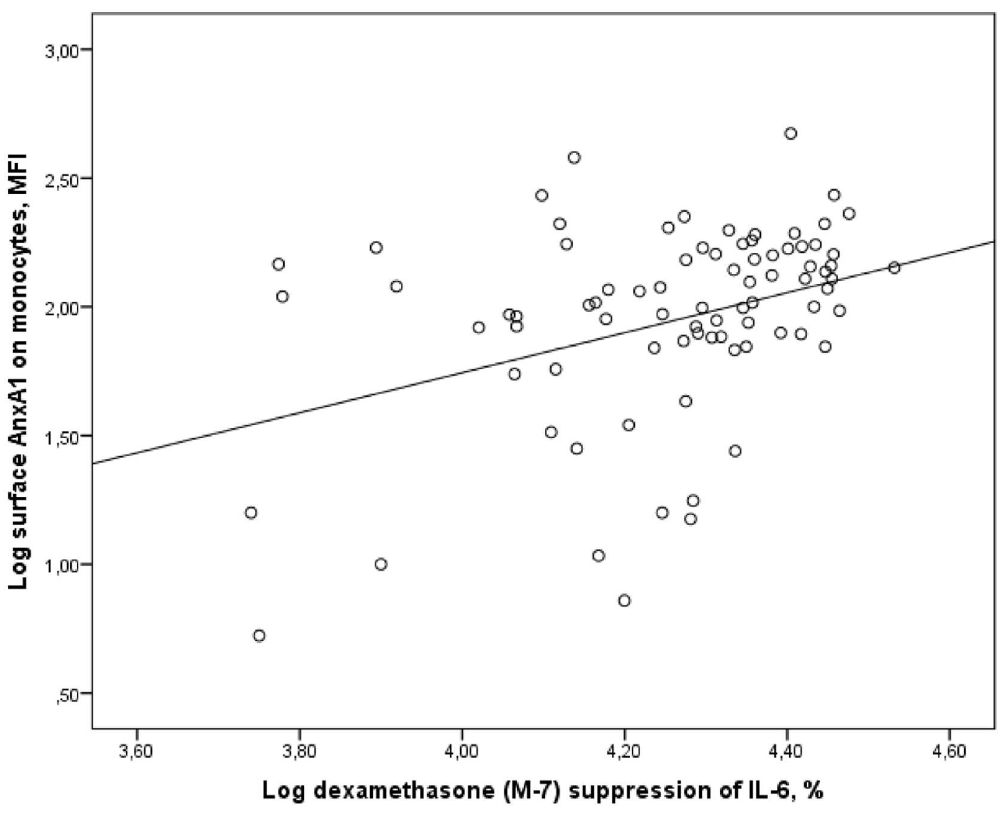
Fig 5. Correlation between surfaceAnxA1 expression on monocytes and glucocorticoid sensitivity. The figure shows the correlationbetweenlog transformed values of MFI values of surface and glucocorticoid sensitivity ex vivo, assessed by dexamethasone (M-7) suppression of LPS-stimulated IL-6 secretionfrom PBMCs (% of LPS- stimulatedlevels), r = 0.340, p = 0.002.